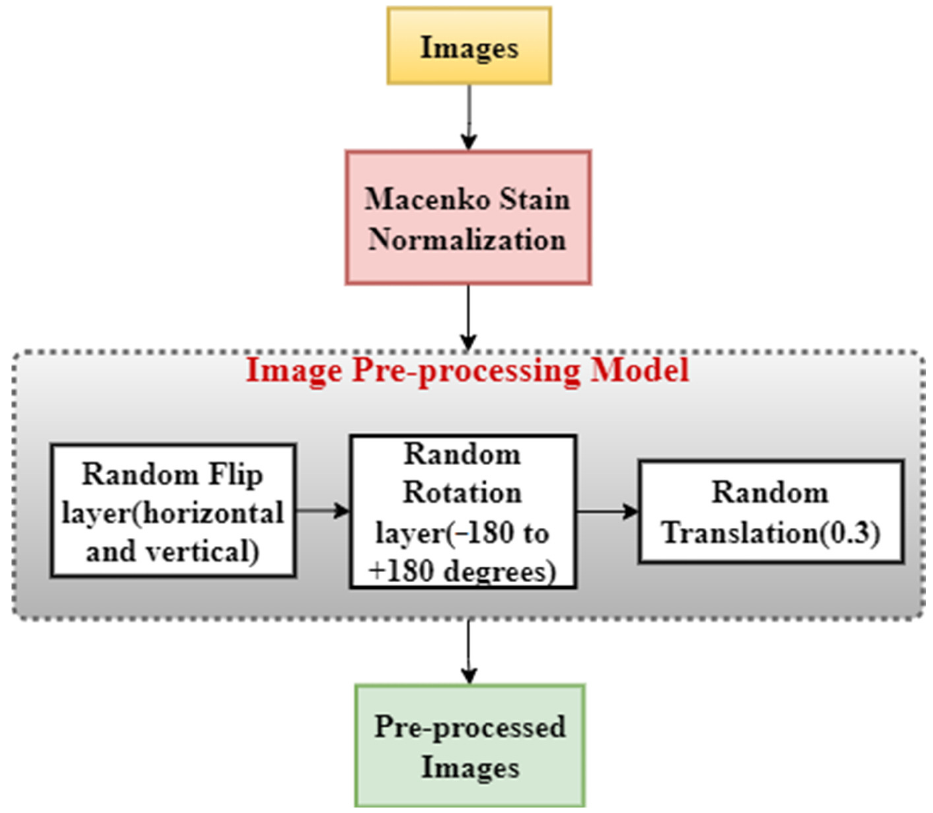
Figure 3. Image pre-processing method that consists of three sequential layers that take images as the input and give pre-processed images as the output. At first, we pass the patches through Macenko stain normalization [39]. This basically converts all the images into the same fixed color space as the template image, which is taken to be one of the patches of the training dataset. This helps to give a constant base and reduce stain varieties across the dataset. This also gives a generic base for the images and helps increase the accuracy of the model. The original image, the stained normalized image, and the separated hematoxylin and eosin stain are all shown in Figure 4. The normalized image has a more contrasting effect that is even easier for the human eye to recognize than that of the original image. These random layers help to increase variety in the training dataset and help in generalizing the training dataset, which ultimately increases the size and orientation of training data and helps the model learn a greater variety of images. This increases the overall accuracy of the patch prediction model and prevents the model from over-fitting the training